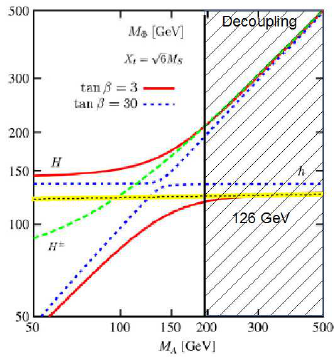
Figure 1: MSSM model Higgs masses, the hatched area indicates the decoupling SUSY parameters space m A > 2 M Z (Adapted from Ref.